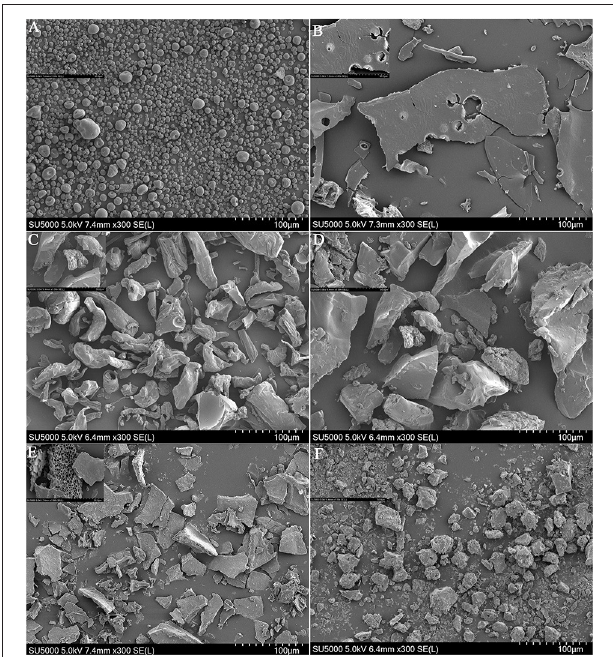
FIGURE 2 | SEM micrographs of (A) xylan (XY), (B) carboxymethylated xylan (c-XY), (C) citrus pectin (CP), (D) carboxymethylated citrus pectin (c-CP), (E) crude water soluble polysaccharides of Passiflora edulis peel (WPEP) samples, (F) carboxymethylated crude water soluble polysaccharides oPfassiflora edulis peel (c-WPEP) samples; magnification factor: 300 ×